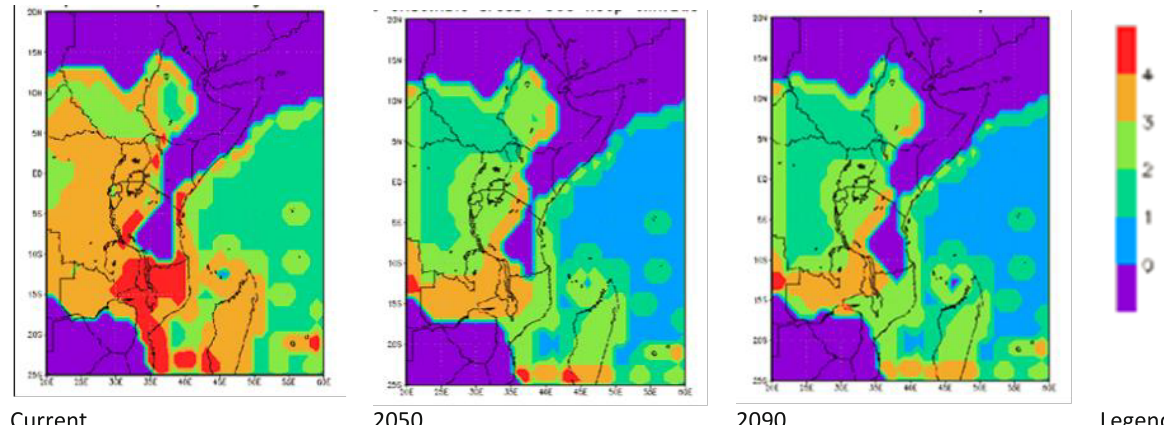
Figure 4: Suitability of sweet potato cultivation in East Africa under high emissions scenario (source: Washington et al. 2012. Ensemble sresb1 JAPRE Climatic Growth Area). Scale: 0 = not adapted, 4 = optimally adapted